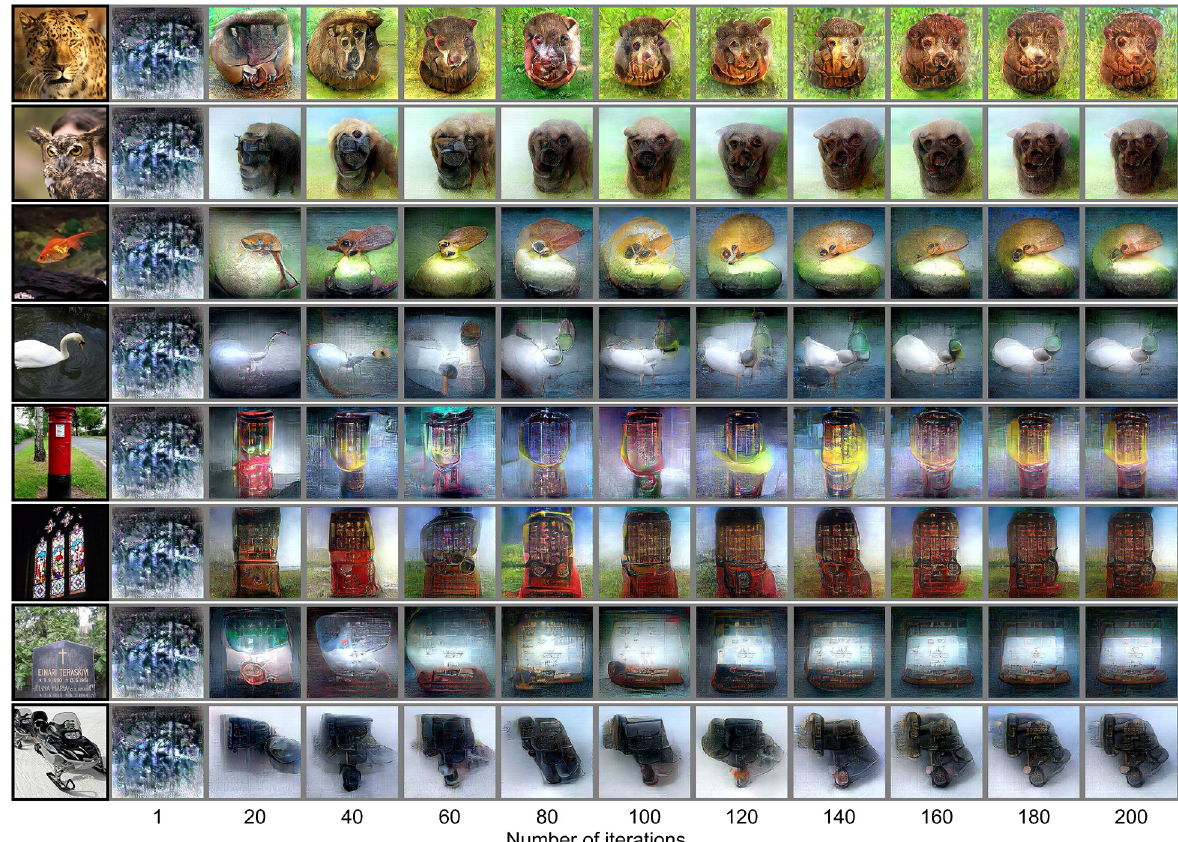
Fig 2. Seen natural image reconstructions. The black and gray surrounding frames indicate presented and reconstructed images respectively (reconstructed from VC activity using DNN1–8). Reconstructed images obtained through the optimization processes are shown for seen natural images. Reconstructions were constrained by the DGN.